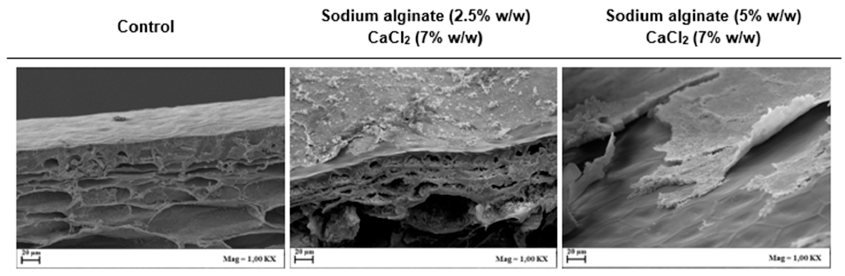
Figure 3. Scanning electron microscopy (SEM) of tomato peels without coating (control) and with sodium chloride coating at different sodium alginate concentrations at fixed dipping time (120 sec).